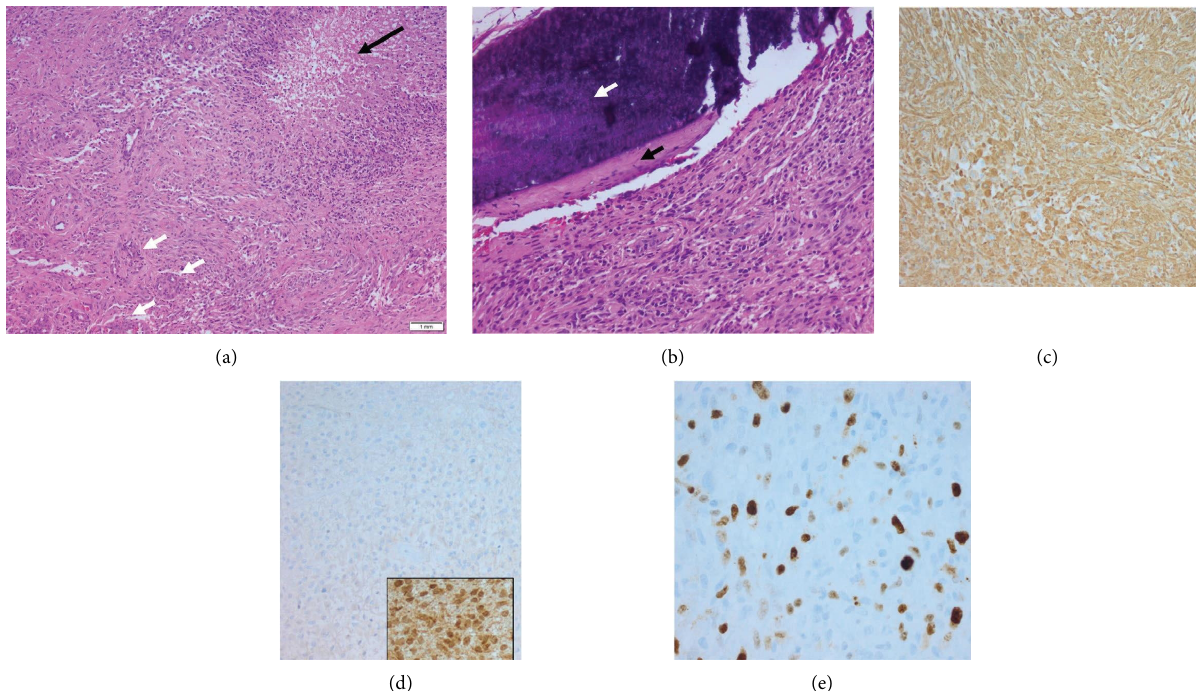
Figure 3: (a) HE staining showing a malignant glial tumor with histomorphological features of a glioblastoma, IDH wild-type (CNS WHO Grade 4). Black arrow: palisading necrosis. White arrows: microvascular proliferation. (b) Te tumor shows areas with close association to fragments of the dura (black arrow) and bone (white arrow) (HE staining). (c) GFAP immunohistochemistry confrms the glial tumor cells. (d) No IDH1 mutation (R132H); inset in (d) on slide positive control. (e) Ki67 immunostaining highlights increased proliferation